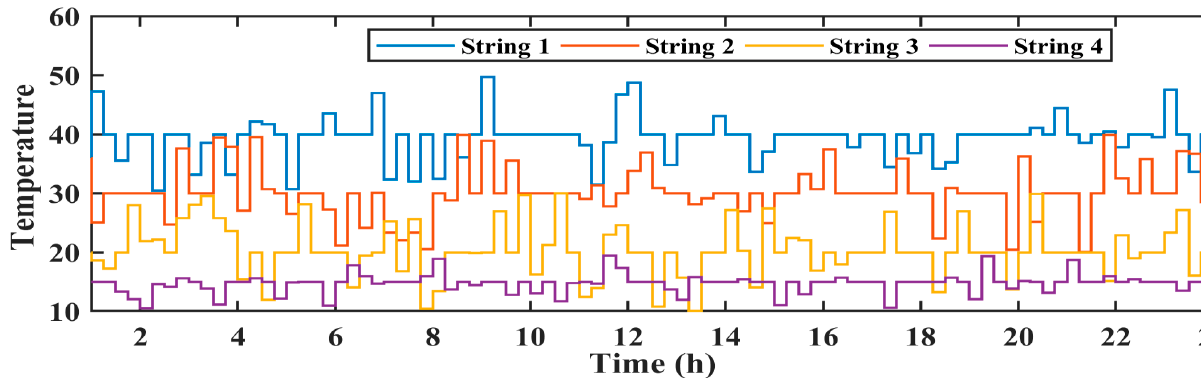
Figure 15. Temperature variation of cold side.